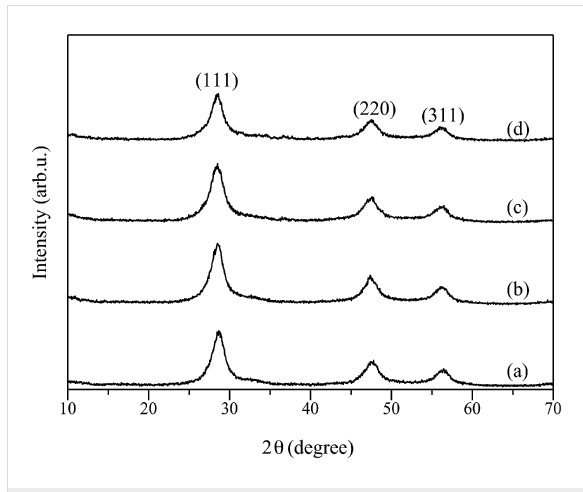
Figure 2: XRD patterns of (a) Cd 0.1 Zn 0.9 S, (b) Ag(0.01)-doped Cd 0.1 Zn 0.9 S, (c) Ag(0.03)-doped Cd 0.1 Zn 0.9 S, and (d) Ag(0.05)-doped Cd 0.1 Zn 0.9 S prepared by the co-precipitation